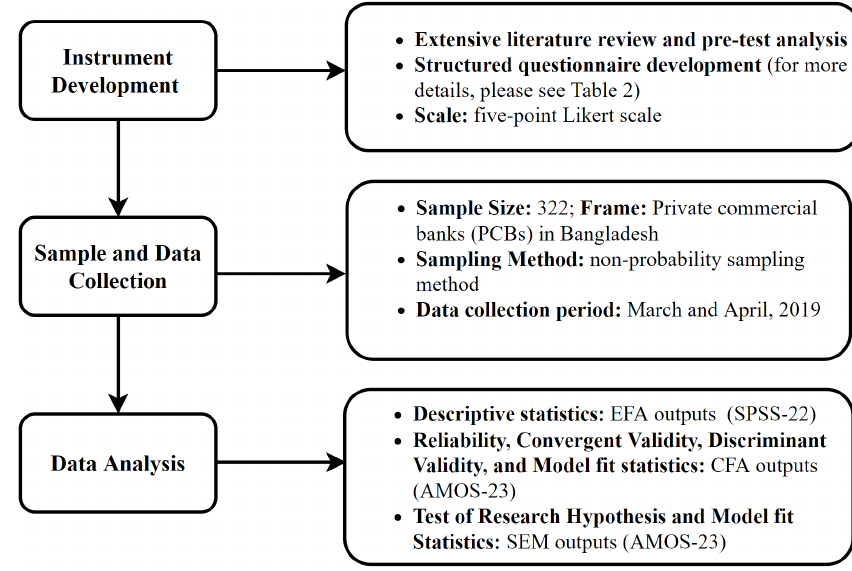
Figure 1. Flowchart of research materials and methods (source: authors’ illustration).